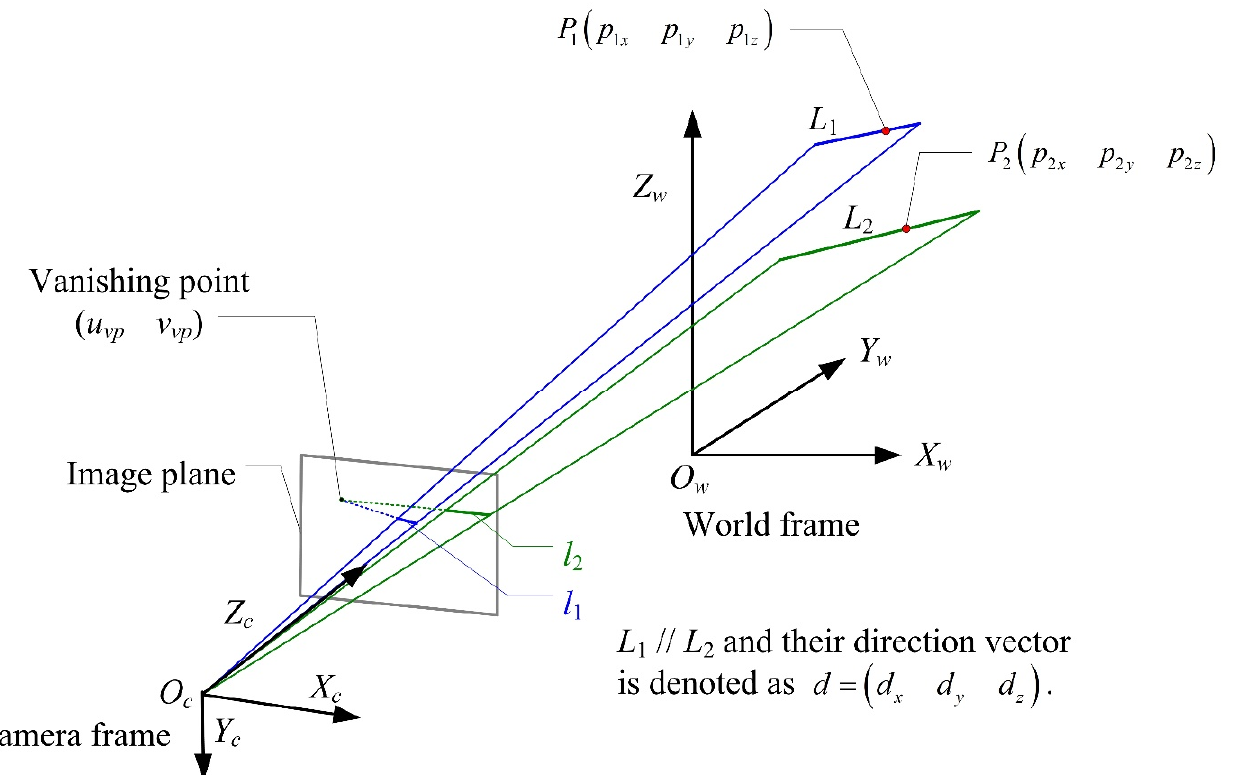
Figure 1. The geometrical drawing of this paper. L 1 // L 2 and their image projections intersect at the vanishing point.